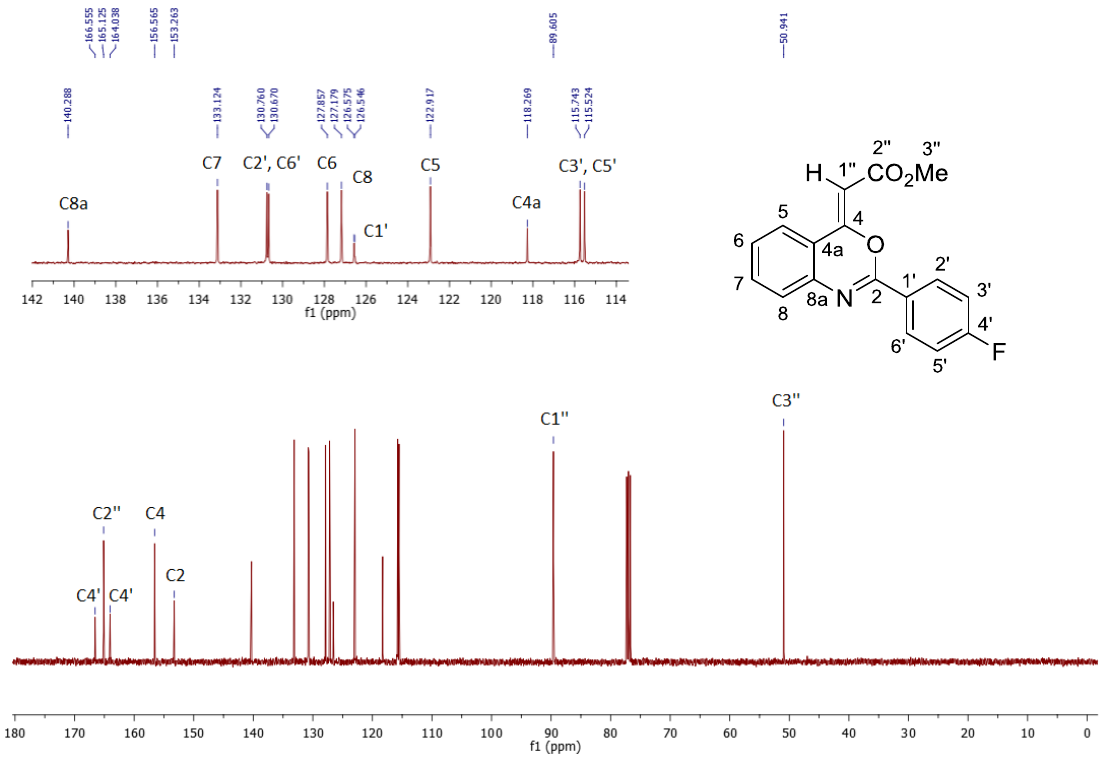
Figure 2. 13 C-NMR spectrum of compound 2 (100 MHz, CDCl 3 ) and related assignments.